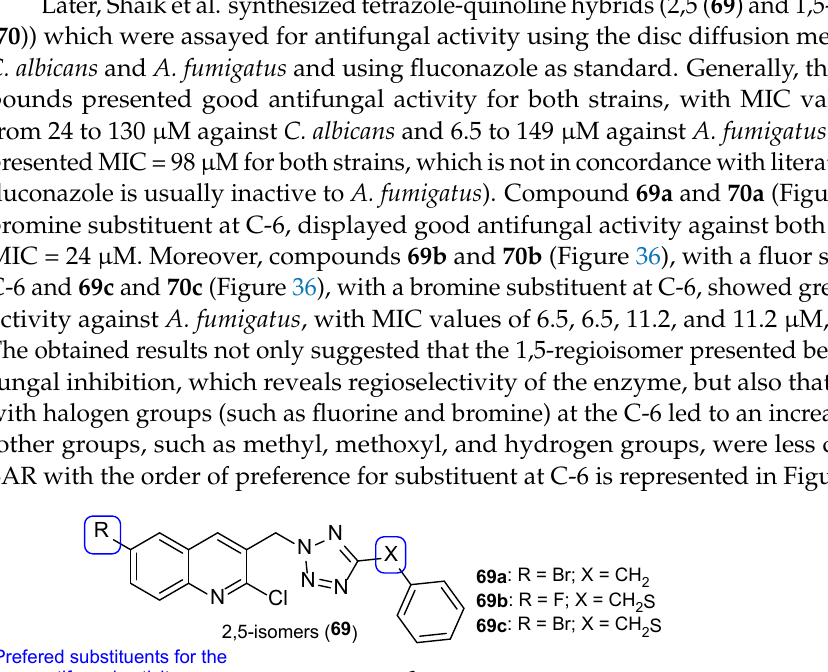
Figure 35. Chemical structures of compounds 67 and 68 and SAR against C. albicans and A. niger [115].